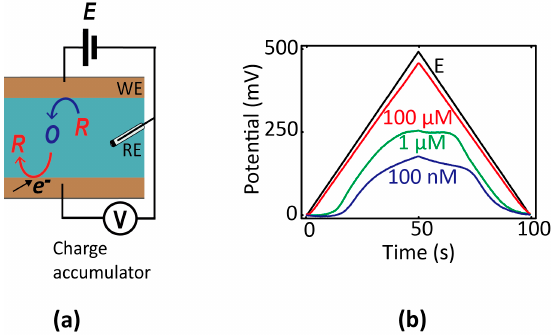
Figure 5. ( a ) Schematic diagram of a two-electrode nanogap system in contact with a solution containing reversible redox species. The bottom (unbiased) electrode accumulates charge over time, and the resulting potential shift is used as readout signal. ( b ) Chronopotentiometric signal versus concentration of redox species (100 µ M, 10 µ M, and 1 nM Fc(MeOH) 2 in 0.1 M KCl) in response to a triangular potential wave applied to the top electrode (black